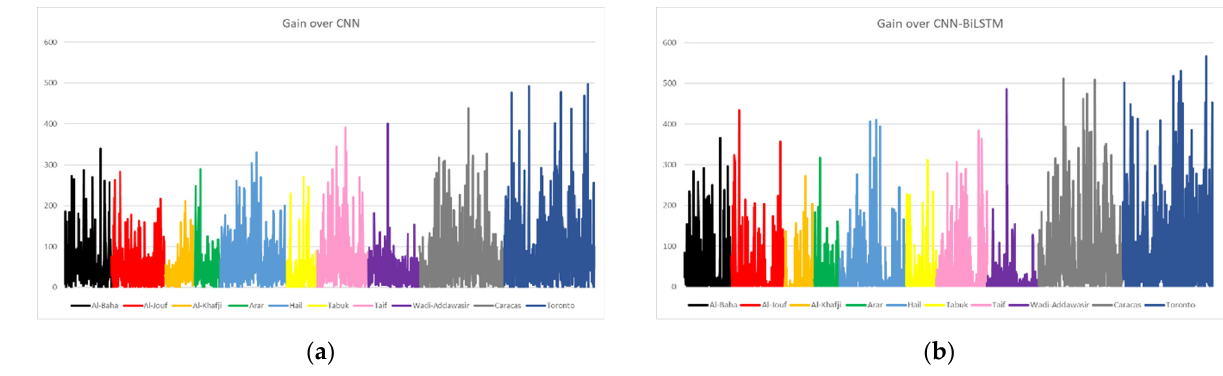
Figure 42. Gain of SENERGY over: ( a ) CNN; ( b ) CNN-BiLSTM.